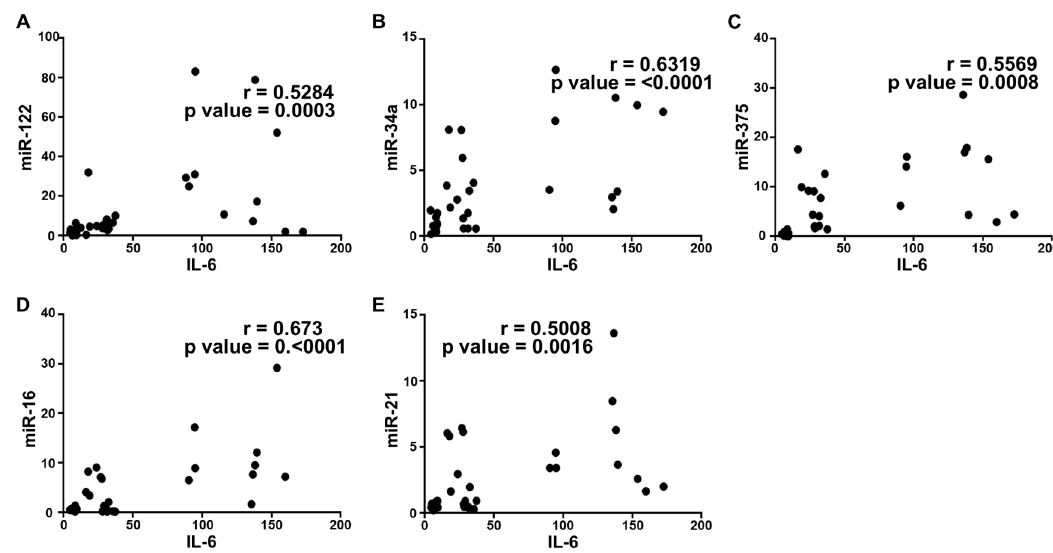
Figure 3. Correlation analysis of IL-6 with circulating miRNAs expression. Correlation was determined using Pearson’s r coefficient choosing two tailed p -value to demonstrate significance (alpha = 0.05). Scatter dot plot between IL-6 and the following: ( A ) miR-122; ( B ) miR-34a; ( C ) miR-375; ( D ) miR-16; and ( E ) miR-21. Each plot independently shows corresponding correlation coefficient (r value) and significance ( p value).